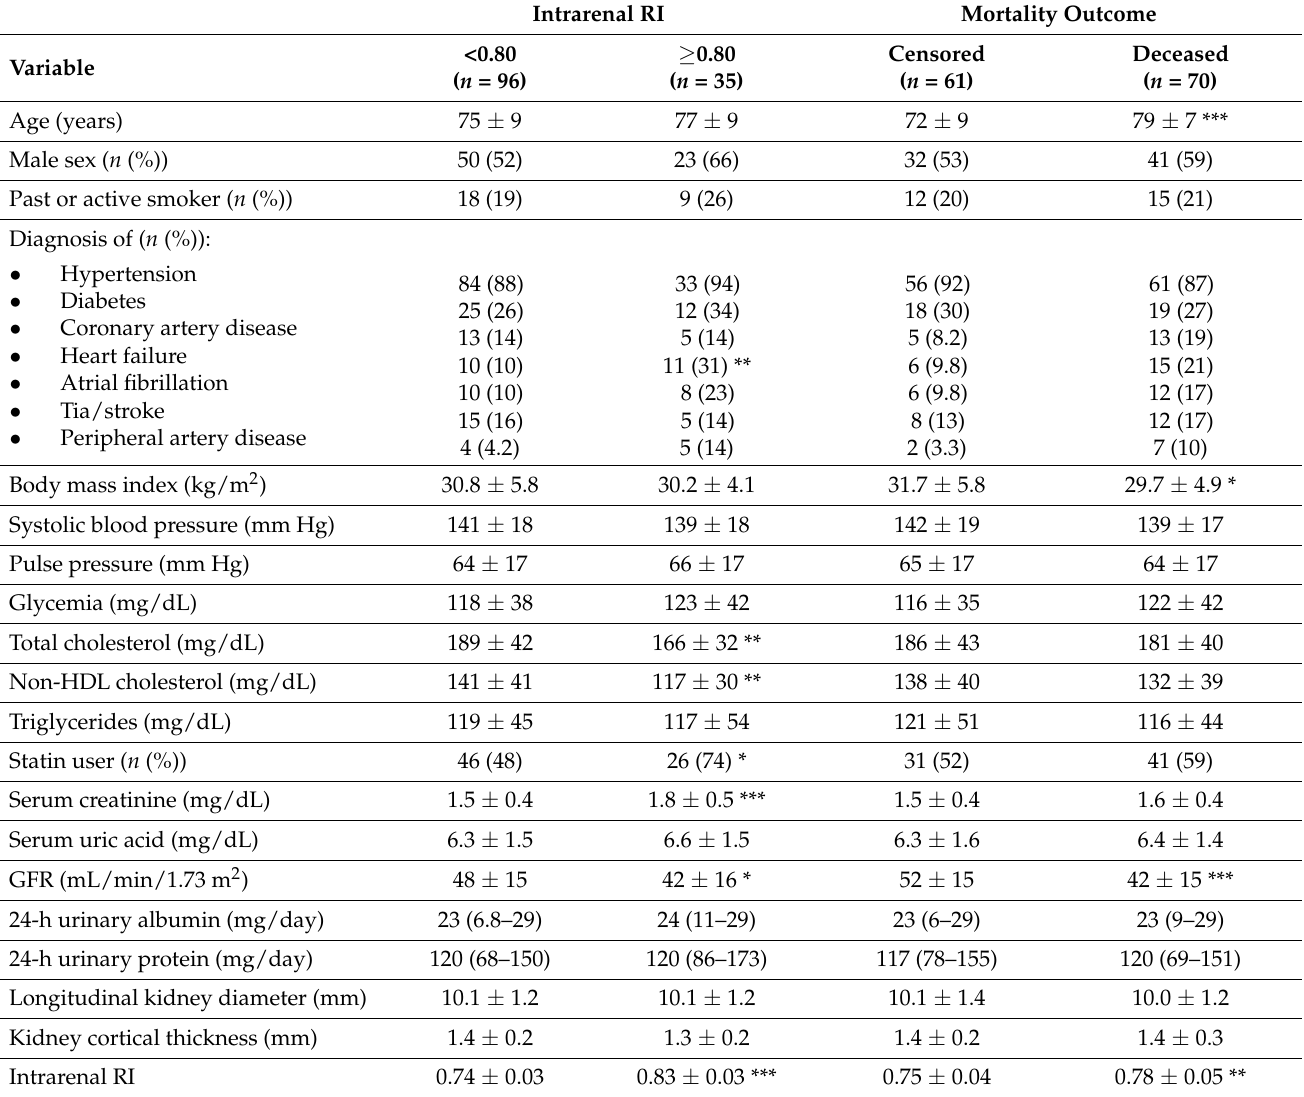
Table 2. Variables description of patients with baseline intrarenal RI above or below the cut-off of 0.80 and between alive/censored or deceased at the end of follow-up. Intrarenal RI Mortality